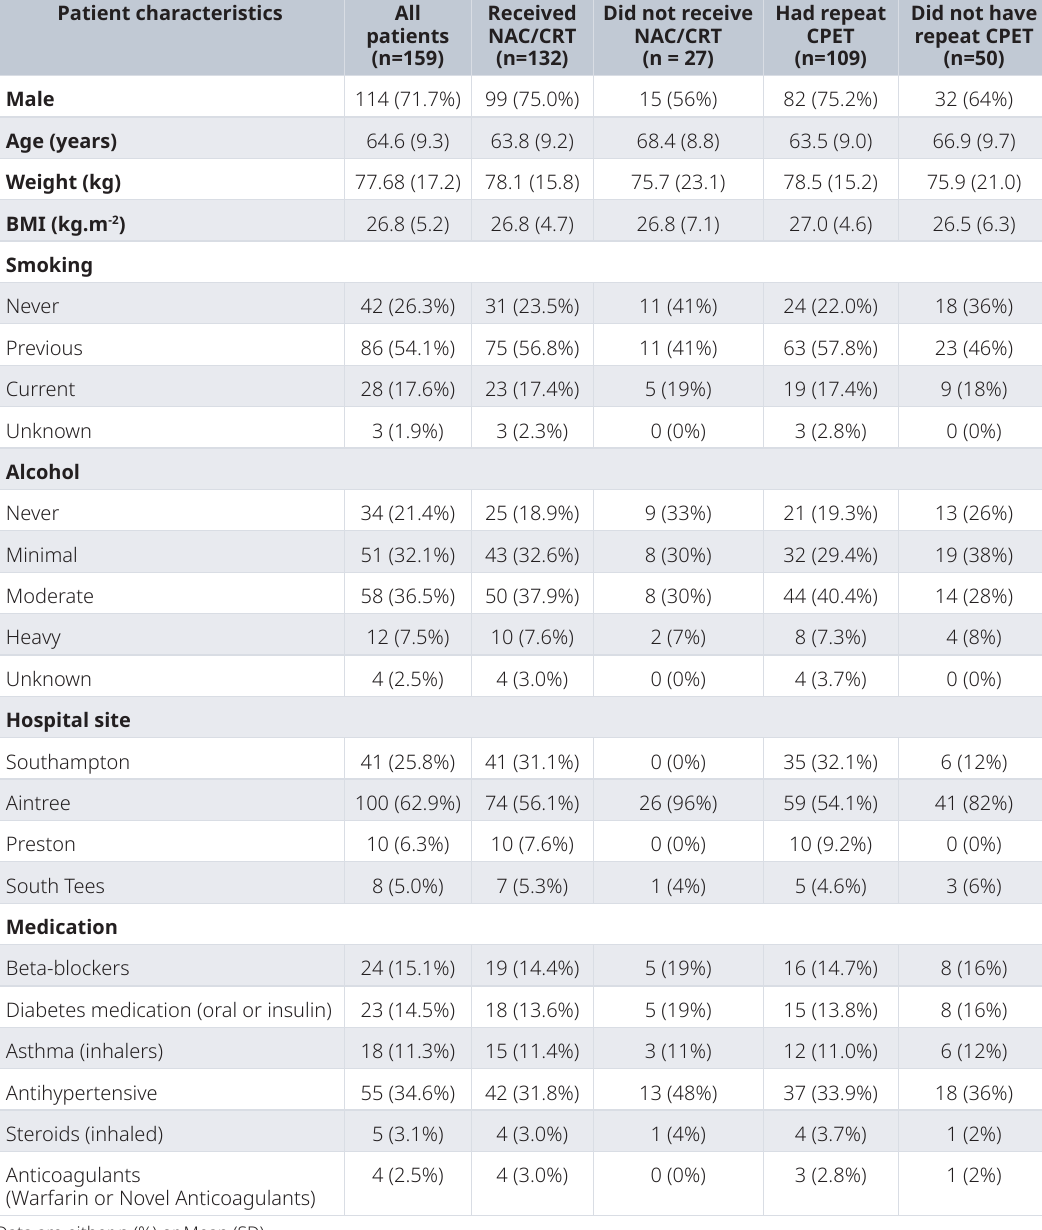
Table 1. Characteristics of all recruited patients, including patients that completed neoadjuvant chemotherapy/chemoradiotherapy and cardiopulmonary exercise testing